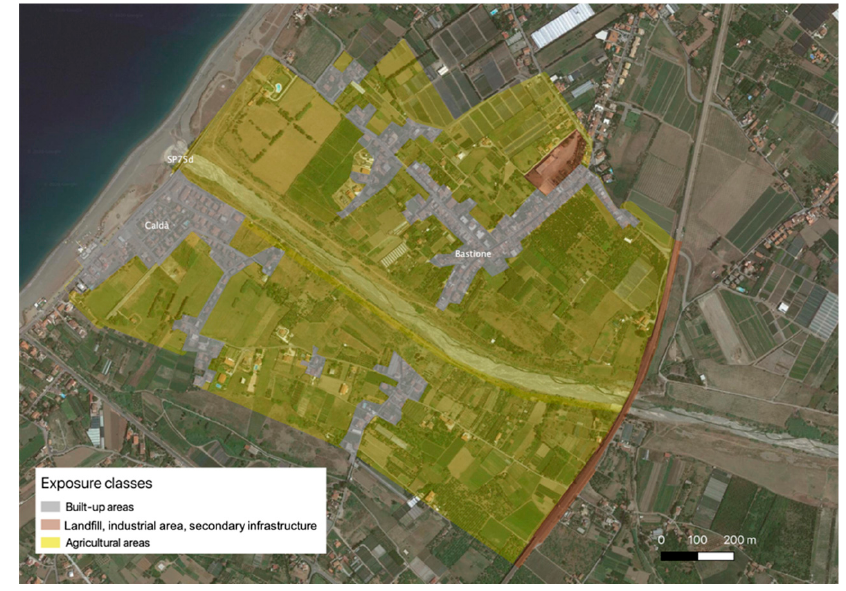
Figure 9. Exposure classes for the study area.